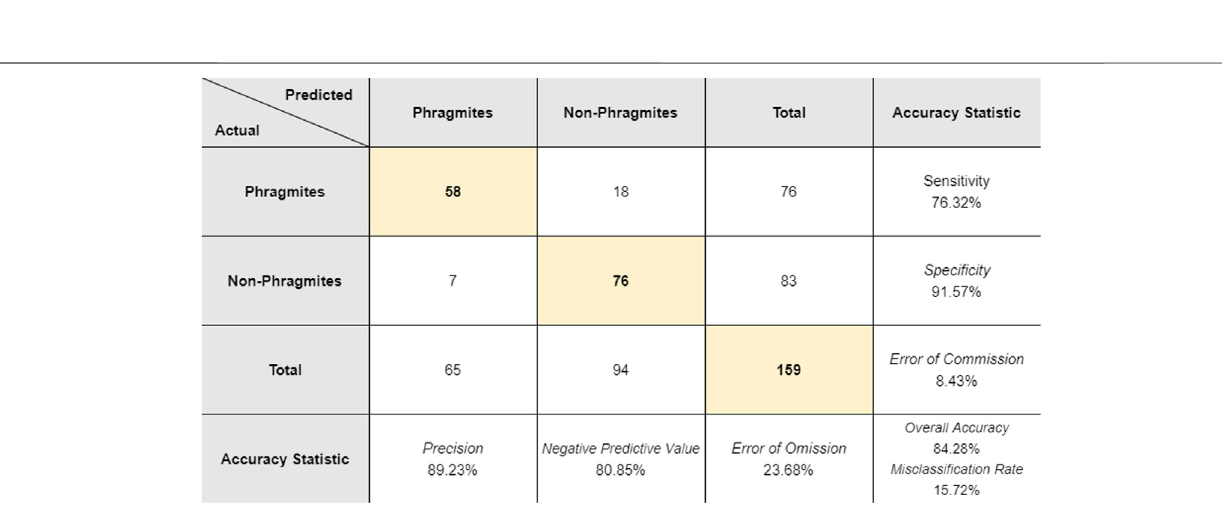
FIGURE 9 | The actual and predicted points for the two scenarios (non- Phragmites and Phragmites ) for the set of 159 validation ground truth points. The highlighted values on the diagonal represent the number of true positives and true negatives out of the total sample size. Calculated accuracy statistics are shown in the last row and last